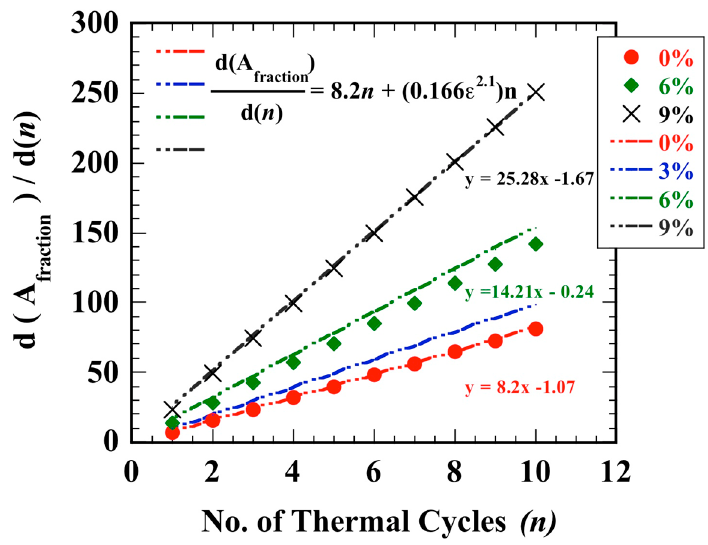
Figure 8. Rate of abnormal grain growth for low strained Ni-200 as a function of the number of thermal annealing cycles.